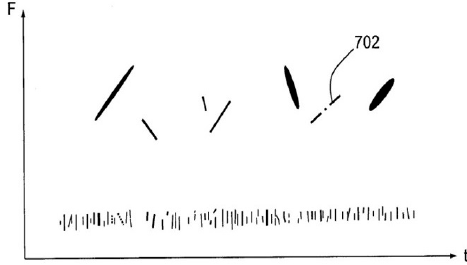
Figure 6. Example of time-frequency plot in Renard et al. [27]. See also Baral-Baron [28]. Second, we model an experiment where the beam waist position and radius are varied (for constant beam width at the lens); the target is modelled as randomly generated scatterers (of equal reflectance) within a box that encloses the waist as described above. The scatterer density (m − 3 ) is constant on average. We see in Figure 7 the variations in probe volume, CNR, and normalised second